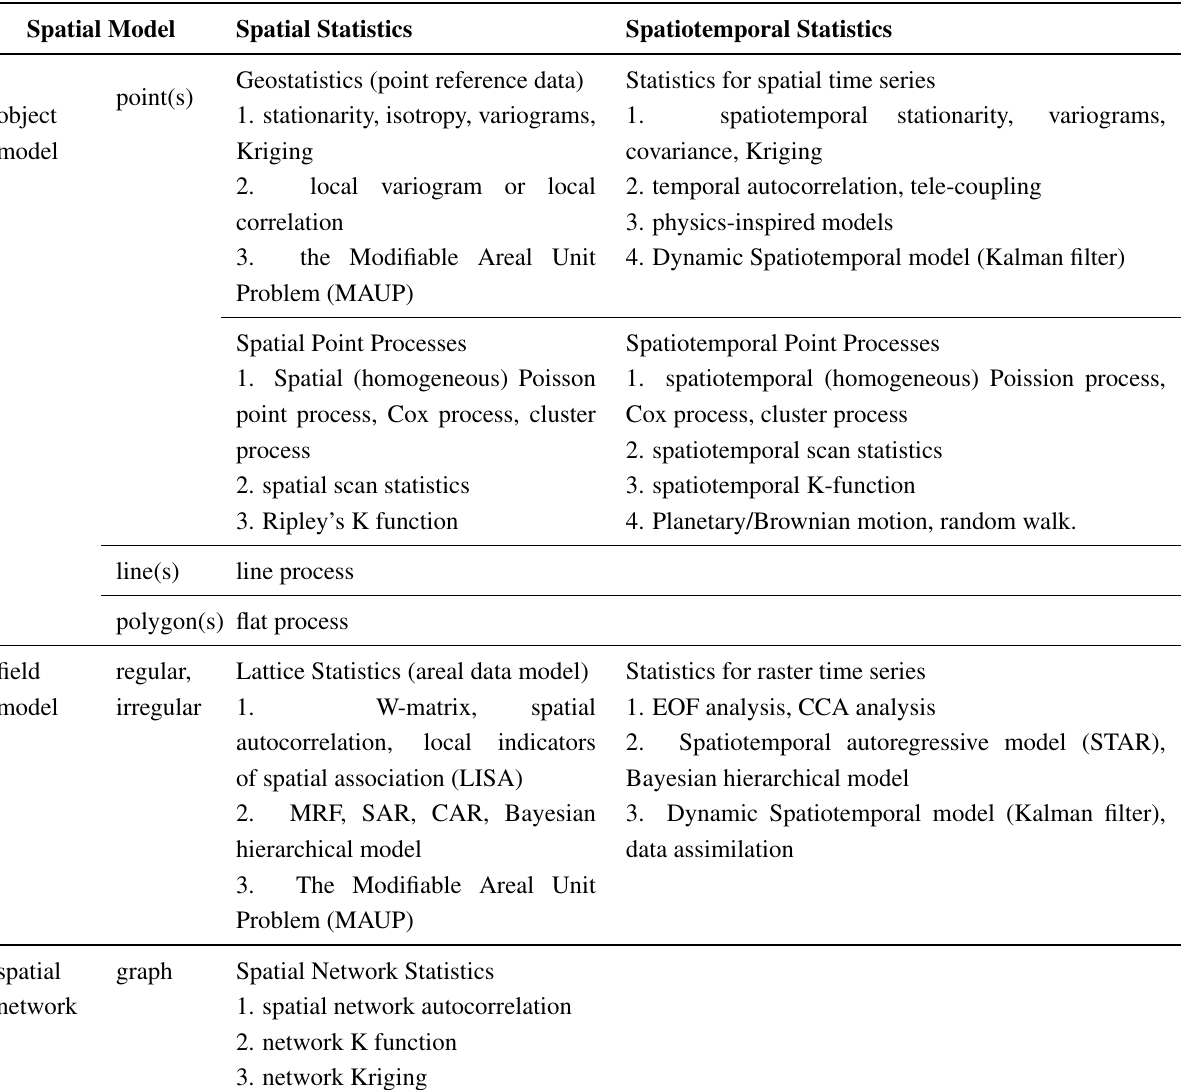
Table 4. Taxonomy of Spatial and Spatiotemporal